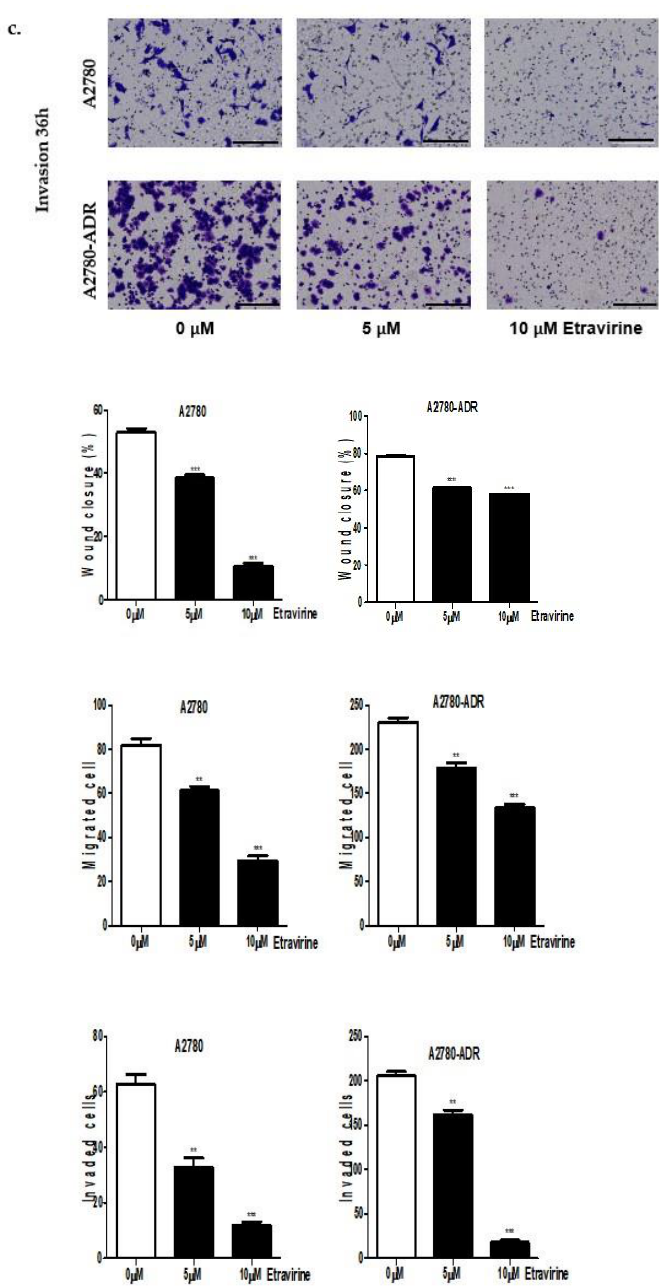
Figure 5. Etravirine inhibits ovarian cell migration and invasion. ( a ) The wound-healing assay showed that the wound closure rate significantly decreased with 5 and 10 µ M etravirine compared to the untreated control in the 24 h time course in A2780 and A2780-ADR cells. ( b ) Transwell migration assay demonstrated that etravirine reduced the number of migrated cells in the group treated with 5 and 10 µ M etravirine compared with that in the control group. ( c ) Transwell invasion assay illustrated that etravirine inhibited the number of invaded cells compared to the control. Scar bar = 200 µ m. Data are shown as mean ± SEM. * p < 0.05, ** p < 0.01, *** p < 0.001.